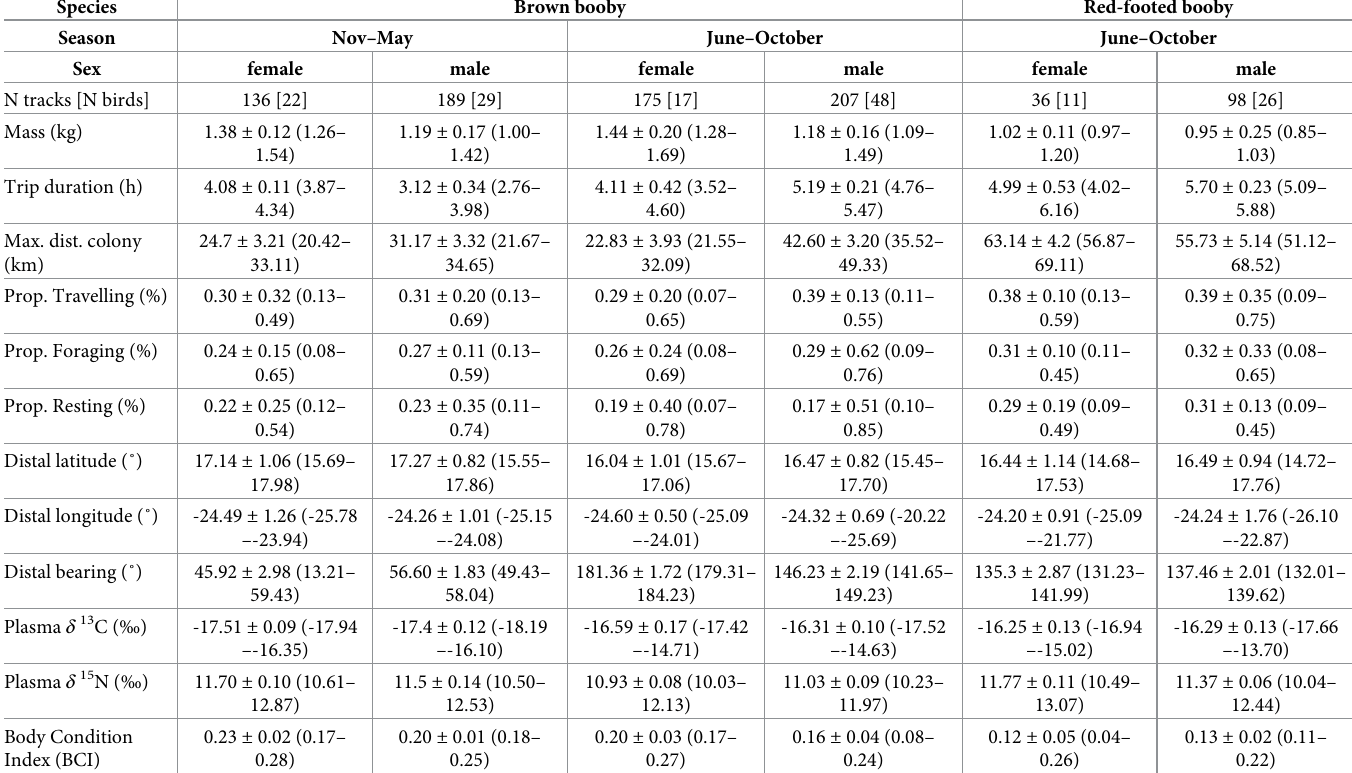
Table 1. Summary statistics (mean ± SD, range in brackets) of trip characteristics, spatial distribution, trophic ecology and body condition of tracked brown (BRBO) and red-footed (RFBO) boobies from Raso Islet, Cabo Verde.